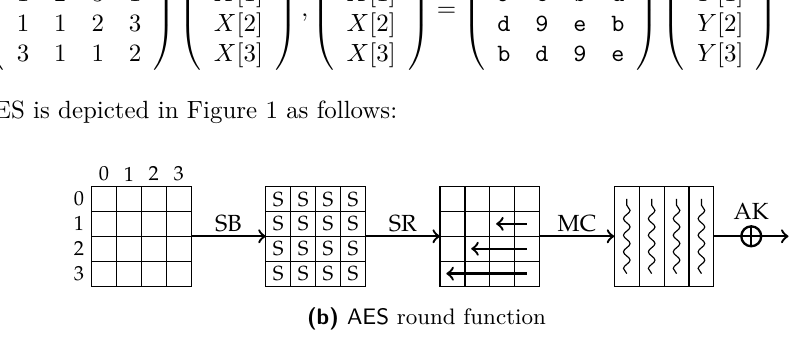
Figure 1: AES byte order and AES round function